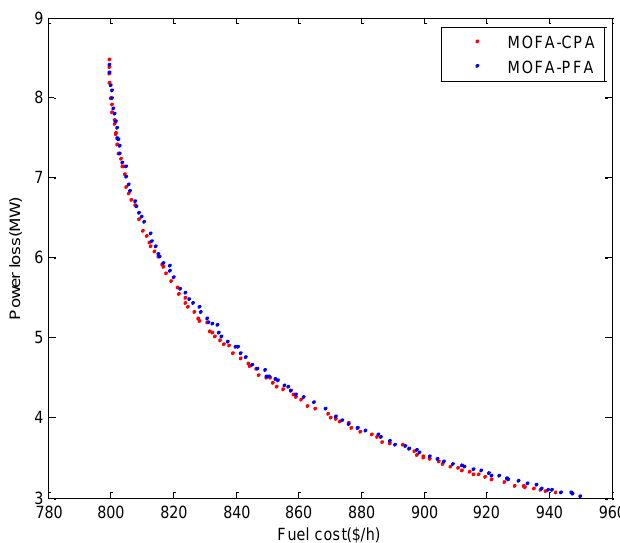
Figure 1. Pareto fronts (PFs) obtained by MOFA-CPA and MOFA-PFA for Case 1.